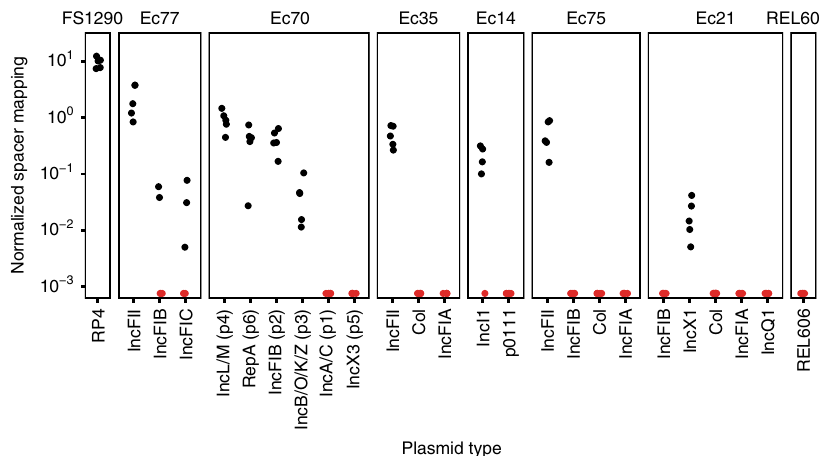
Fig. 3 Recording of HGT events in a de fi ned multispecies community. Spacer recording in a de fi ned community of 8 E. coli strains. Exogenous spacers ( n = 14,463 pooled over 5 biological replicates) were mapped to contigs identi fi ed as plasmids 36 in the 8 genomes allowing only unique hits. Hits were observed for all donors except the negative control REL606, which carries transferrable genetic elements. The normalized spacer mapping is spacers per kb per 1000 exogenous spacers. Red data points denote zero recorded